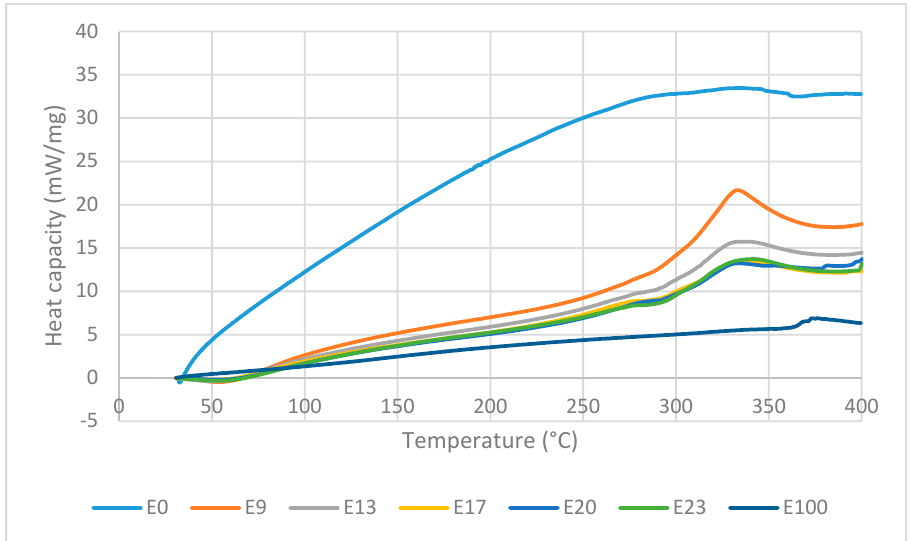
Figure 10. DTA curves of sago fiber-epoxy composites, sago fiber, and epoxy resin.